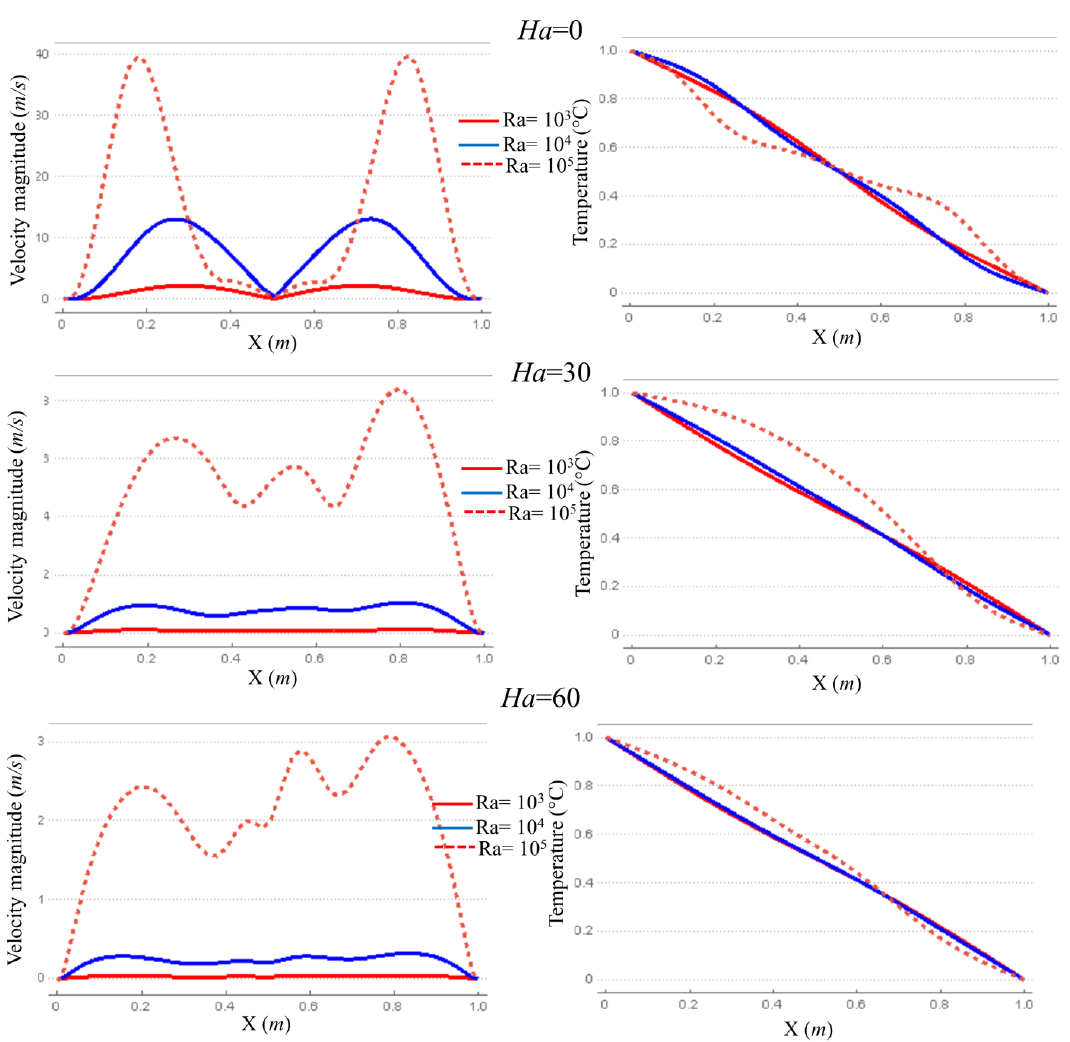
Figure 11. E ff ect of Hartmann number and Rayleigh number on velocity and temperature along the diagonal line.